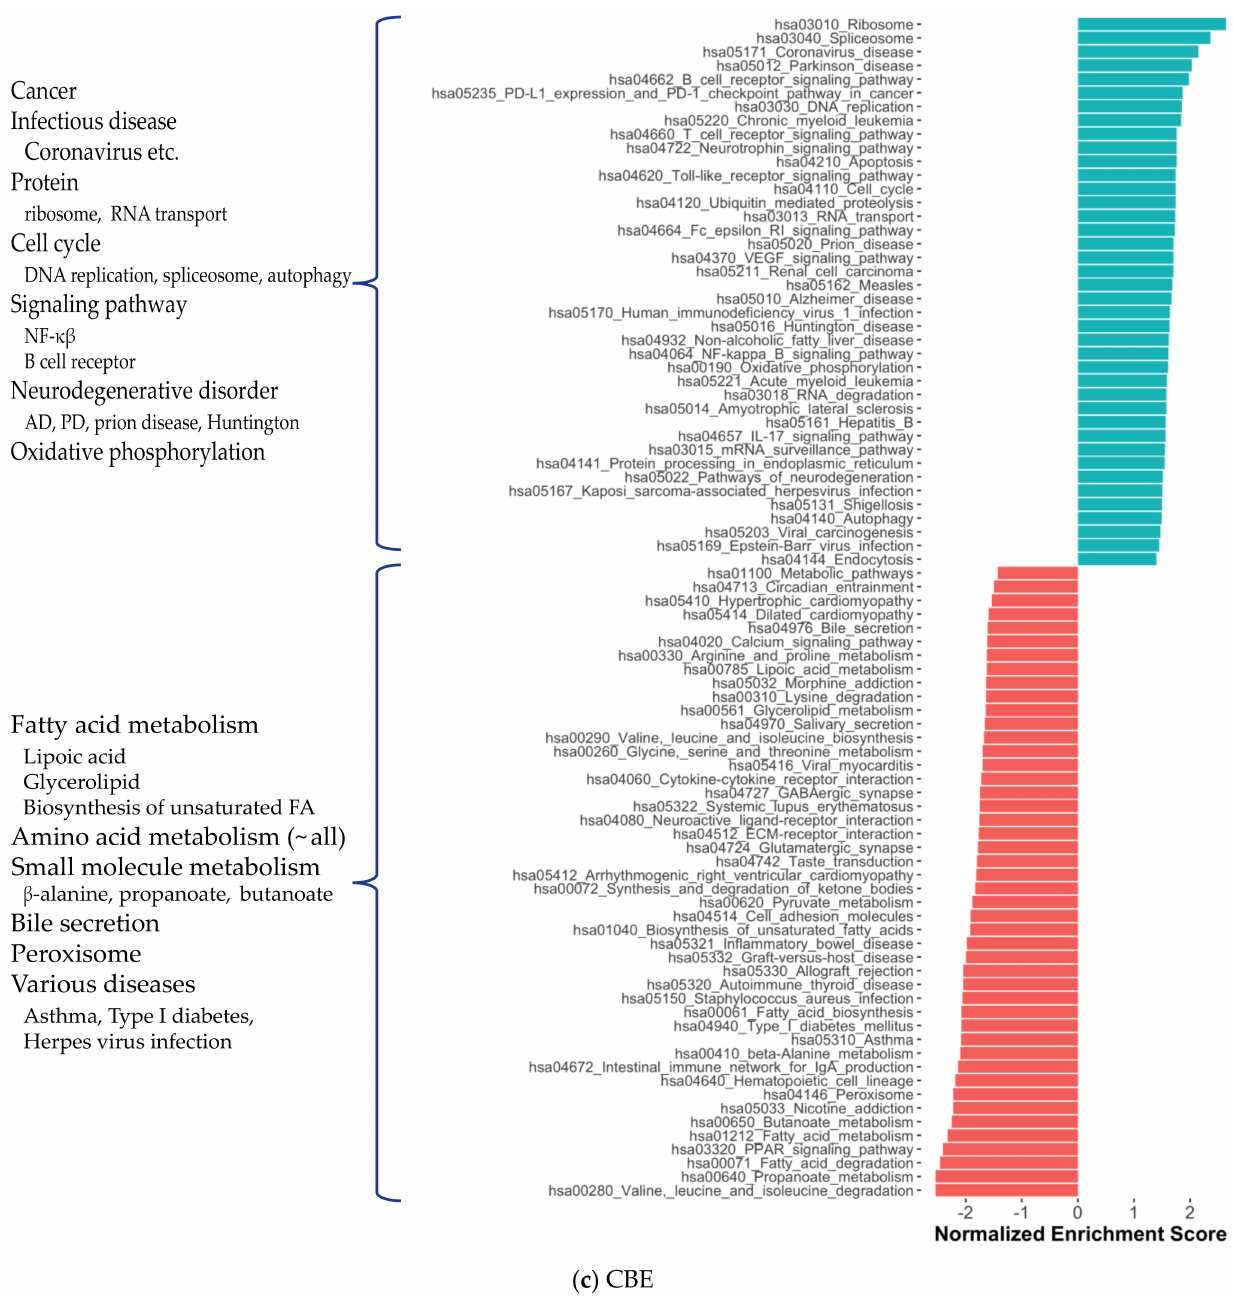
Figure 3. Significantly enriched KEGG pathways for protein-coding genes in DLPFC, TCX and CBE. In parallel, DLPFC and CBE showed abundant GO term enrichment. Cytoskeleton organisation (e.g., actin cytoskeleton organisation), GTPase activity, cell membrane–linked signalling pathways and associated processes (e.g., G protein-coupled receptor signalling pathway, neurotransmitter transport, glutamate receptor signalling pathway) and angio- genesis (e.g., blood vessel morphogenesis, epithelial cell differentiation) were enriched significantly in DLPFC data. We also found the enrichment for cytoskeleton, neuronal regions and respective molecular activity (e.g., microtubule-binding, cadherin binding, Rho GTPase binding) (Figure S6a–c). These enriched pathways indicate changes supporting cholinergic signalling and vascularisation. The enriched pathways in the CBE dataset were similar but scarce compared to DLPFC results (Figure S6d–f). GO enrichment analysis did not yield any significant results for TCX